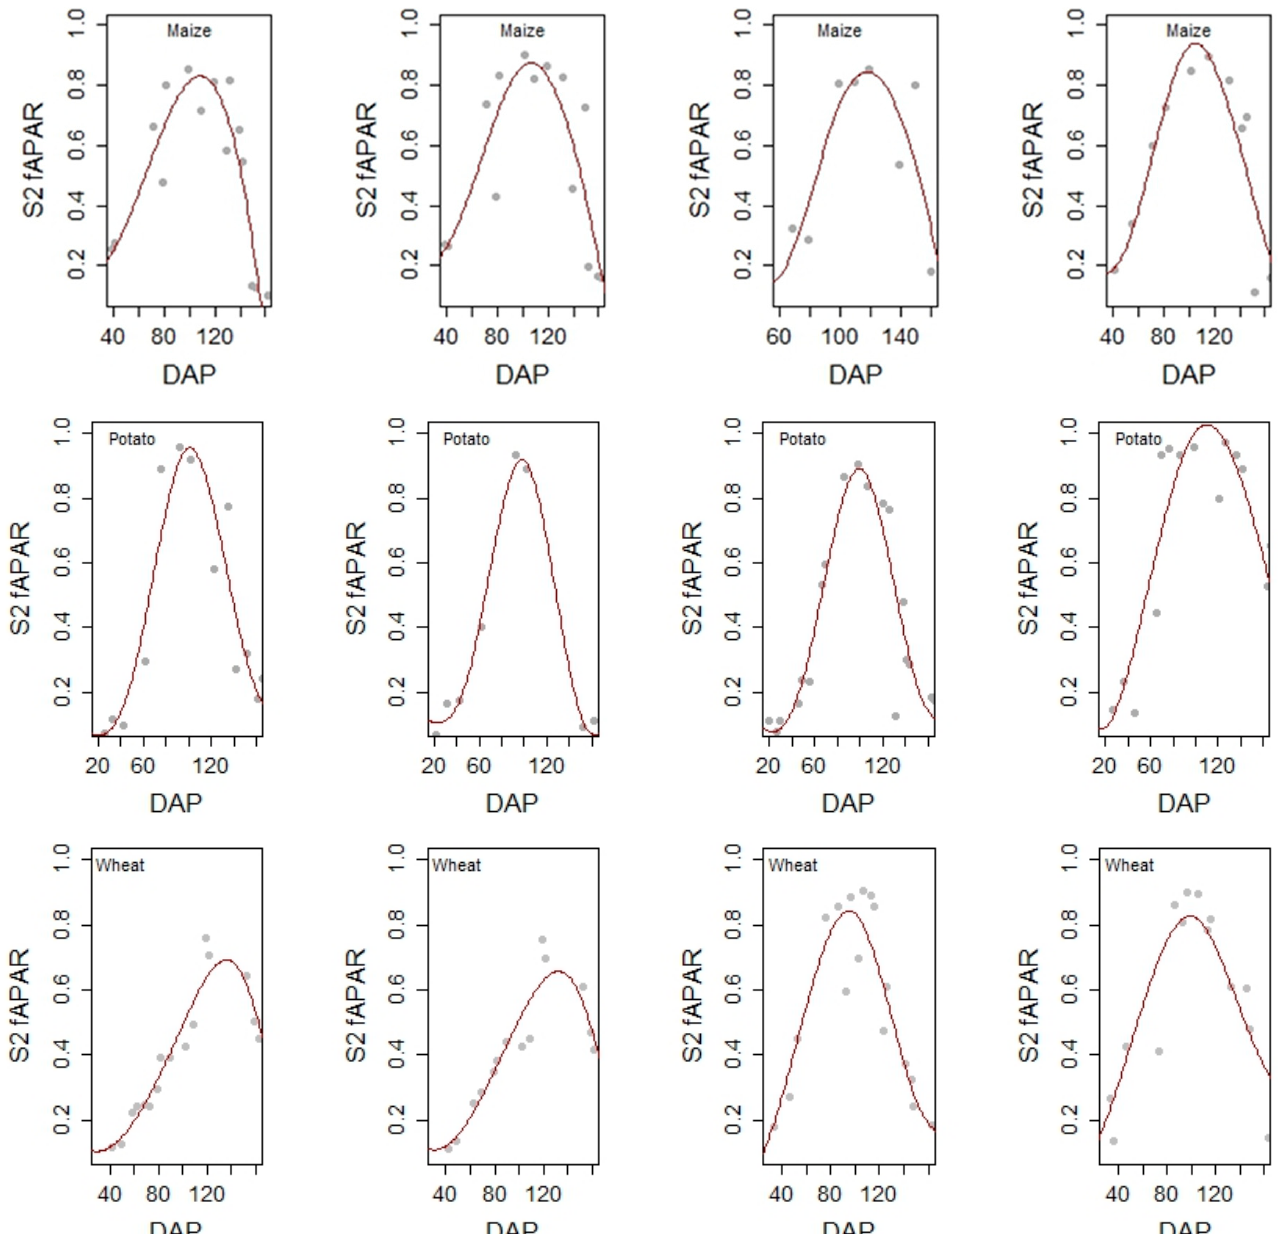
Figure 11. S2-derived fAPAR and cubic splines projected on days after planting/sowing (DAP) for